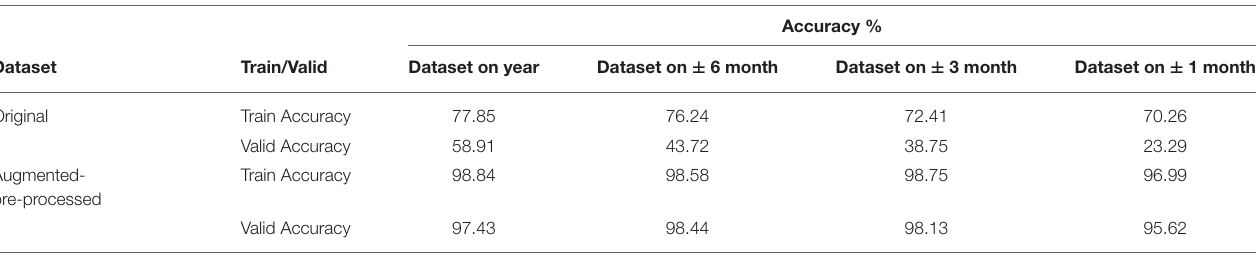
TABLE 2 | Experimental result on a dental dataset based on